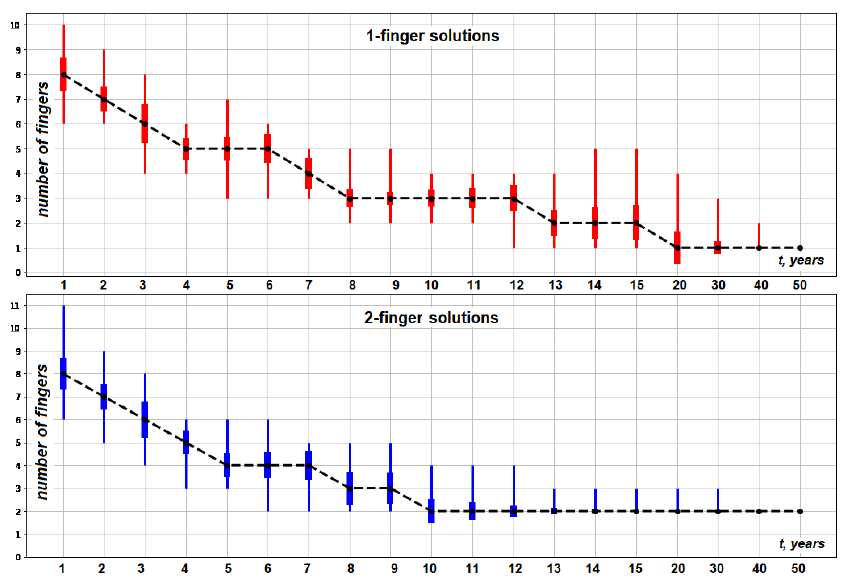
Figure 7. Estimated number of fingers (median, min, max, and stddev) for 1- and 2-finger